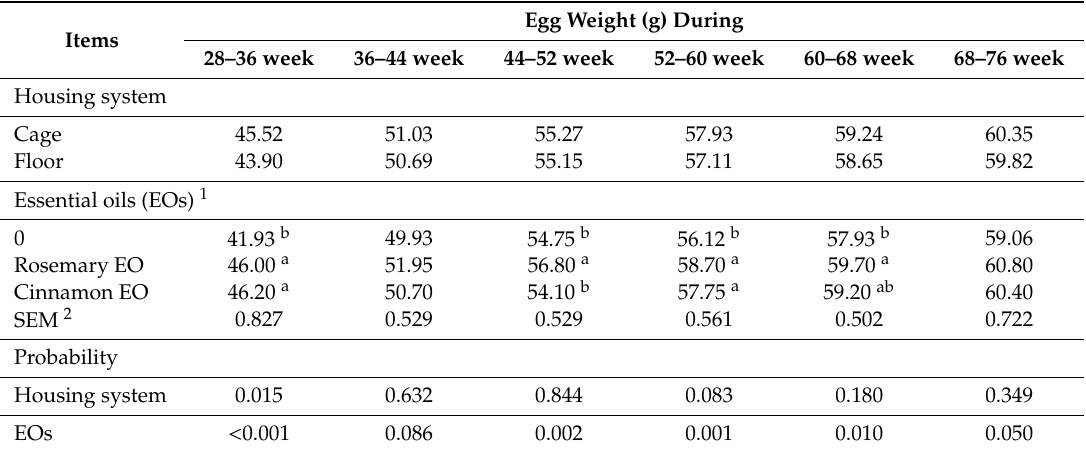
Table 3. Egg weight of laying hens as a ff ected by di ff erent housing systems, essential oils and their interaction during the experiment.